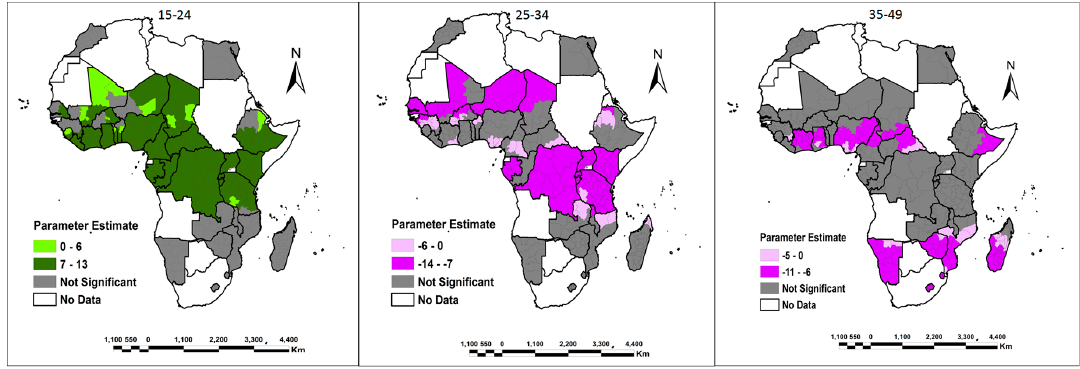
Figure 7. Spatial distribution and significance of age on women’s access to own land.